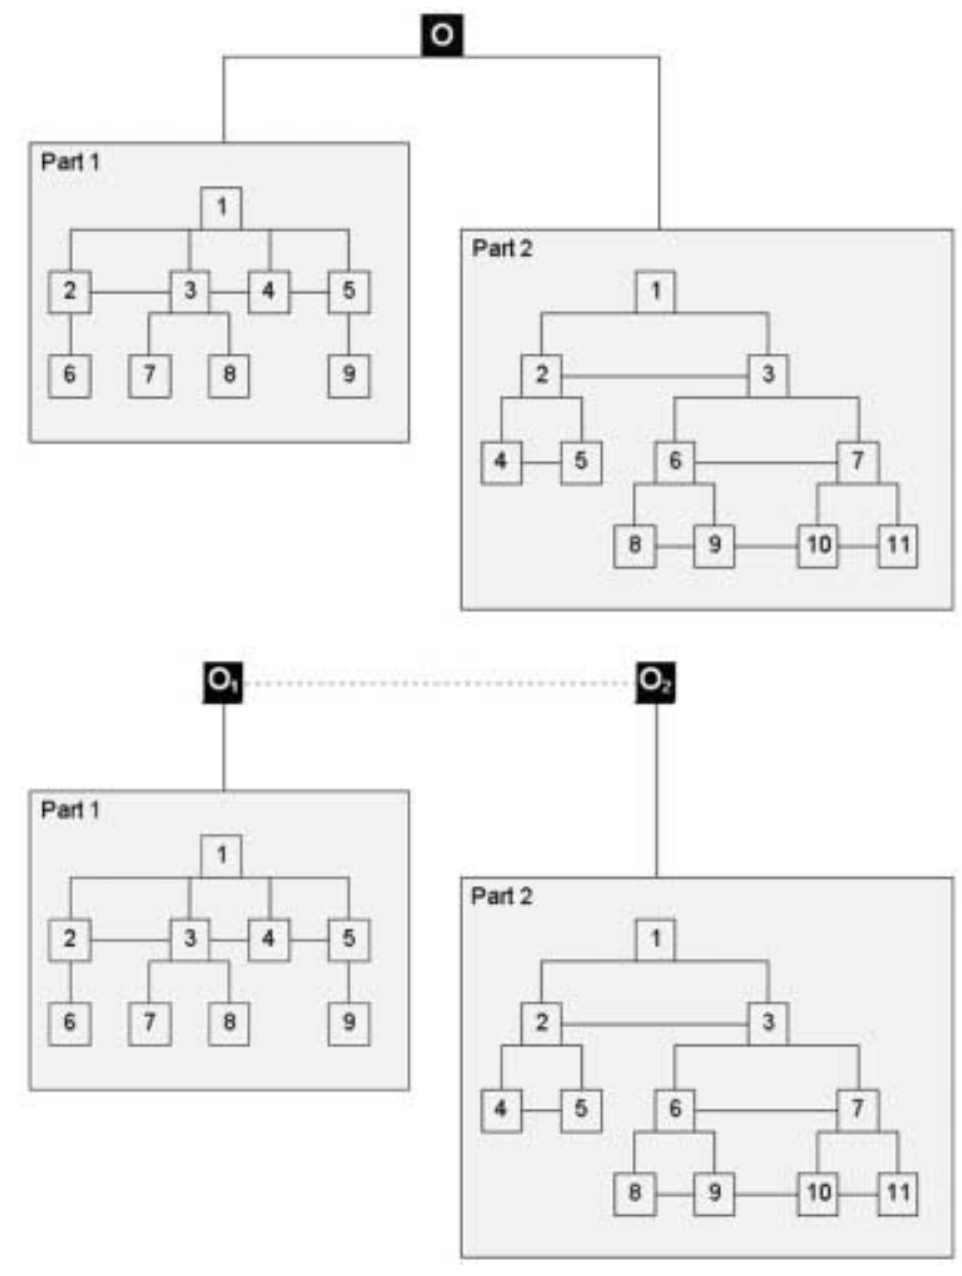
Figure 1. Hierarchical structure of the hypertext and structure of the two experimental conditions: top, free browsing condition; bottom, reduced browsing